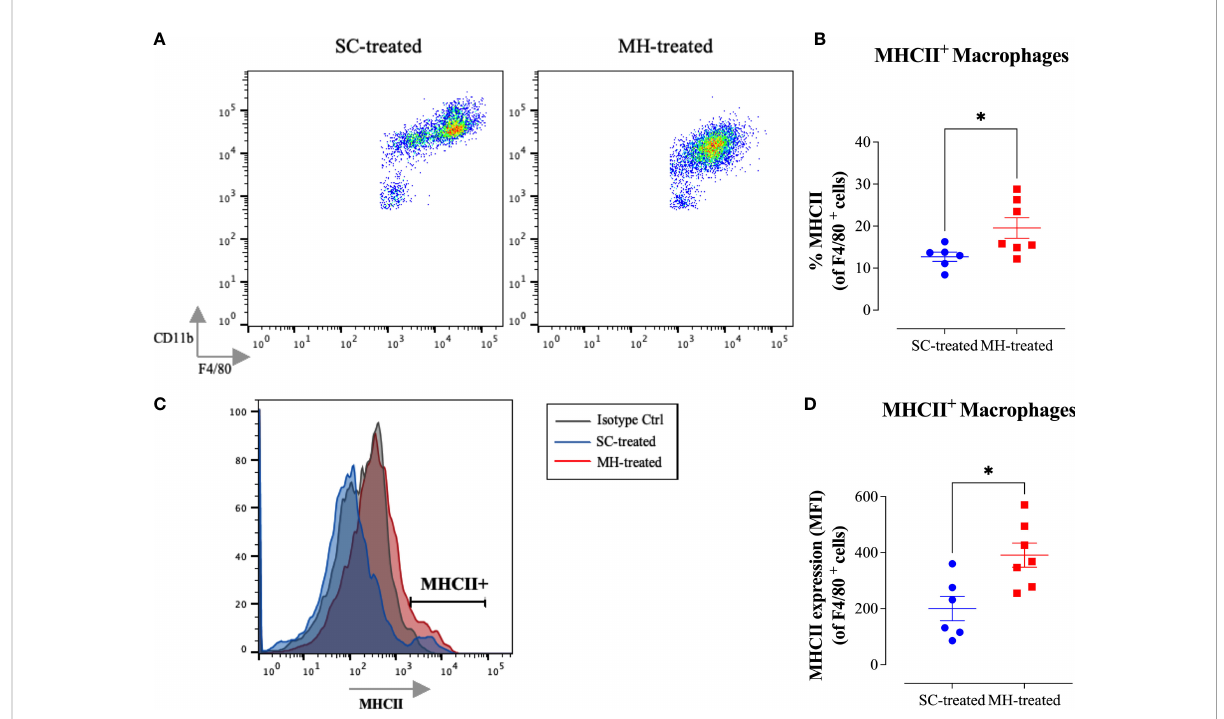
FIGURE 7 MH induces maturation of peritoneal myeloid cells in C3H/HeJ mice. (A) Representative dot plots showing F4/80 + CD11b + cells (gated on macrophages) in SC-treated and MH-treated mice. (B) Representative fl ow cytometric histogram showing MHCII expression on F4/80 + macrophages of SC-treated and MH-treated mice. Grey histogram indicates staining with isotype-matched control antibody. (C, D) Quanti fi cation of the percentage (C) and median fl uorescence intensity (D) of MHC class II + macrophages in SC-treated and MH-treated groups. Asterisks denote statistically signi fi cant differences between the MH-treated group and the SC-treated groups. The values for individual mice in a group ± SEM are shown (SC-treated: n=6, MH-treated: n=7), pooled from 2 individual experiments. p values were calculated using the unpaired Student ’ s t-test (*p ≤